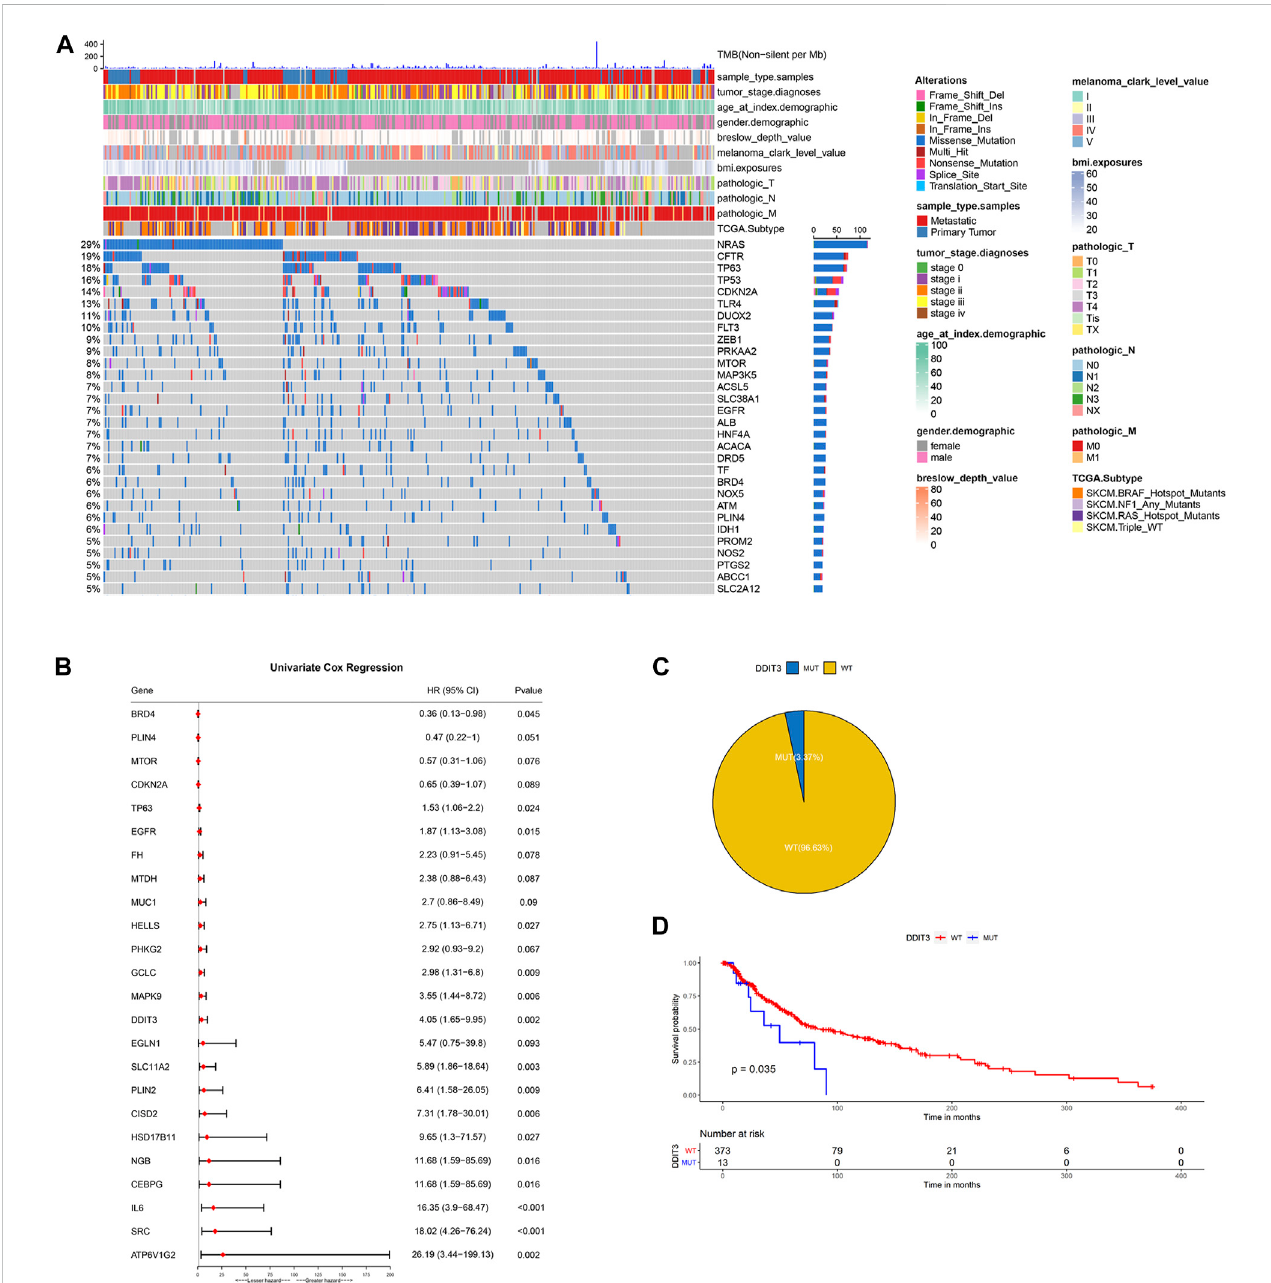
FIGURE 1 Identi fi cationofprognosis-relatedkeyFRGsinSKCM. (A) HeatmaptoshowtheSNVlandscapeofthetop30FGRswiththemostfrequentSNVmutations intheTCGA-SKCMcohort. (B) Forest plotsshowingtheresultsoftheunivariateCoxregressionanalysisbetweenFGRsandprognosis. (C) Piecharts depicting the proportions of wild-type and DDIT3-mutant patients. (D) Kaplan-Meier survival analysis of the wild-type and DDIT3-mutant